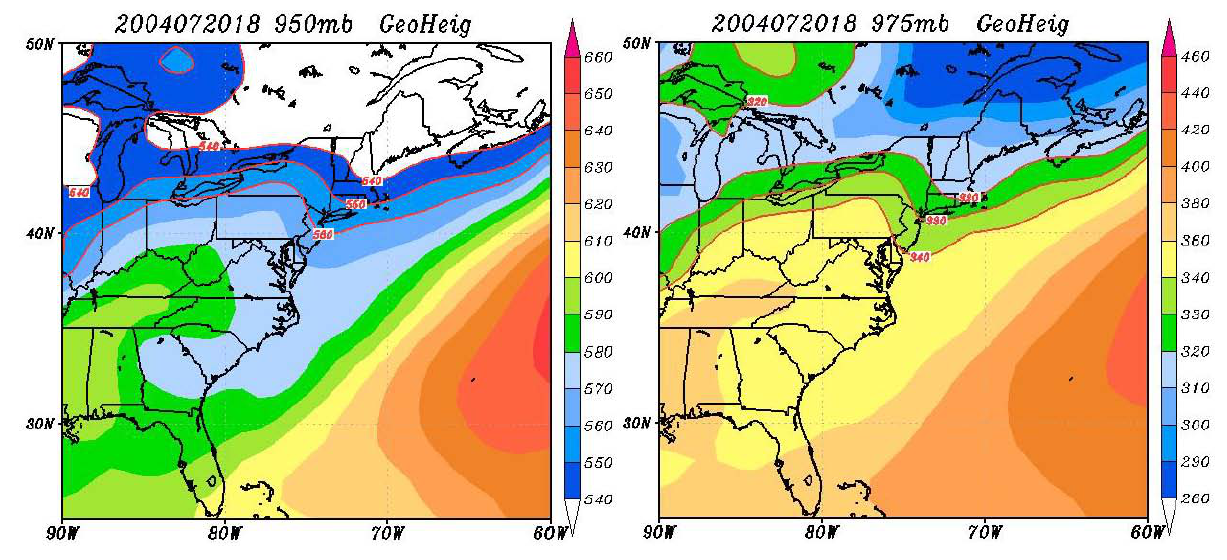
Figure 16. NCEP 1° × 1° geopotential height at 975 mb (right) and 950 mb (left) on 20 July 2004.